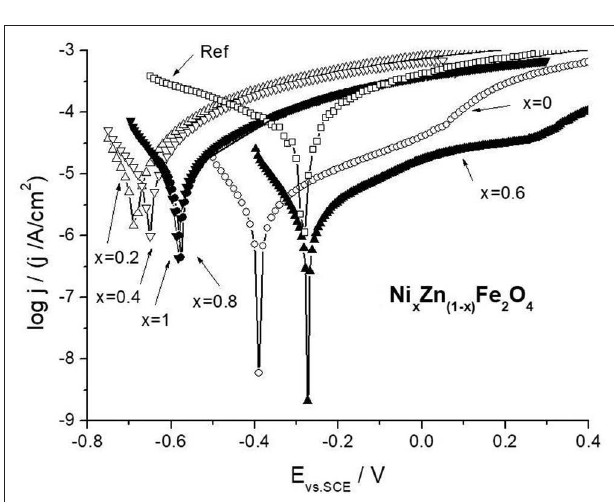
FIGURE 13 | Comparison of potentiodynamic polarization curves for carbon steel in nano-ferrite and nano-Fe 2 O 3 extracts.